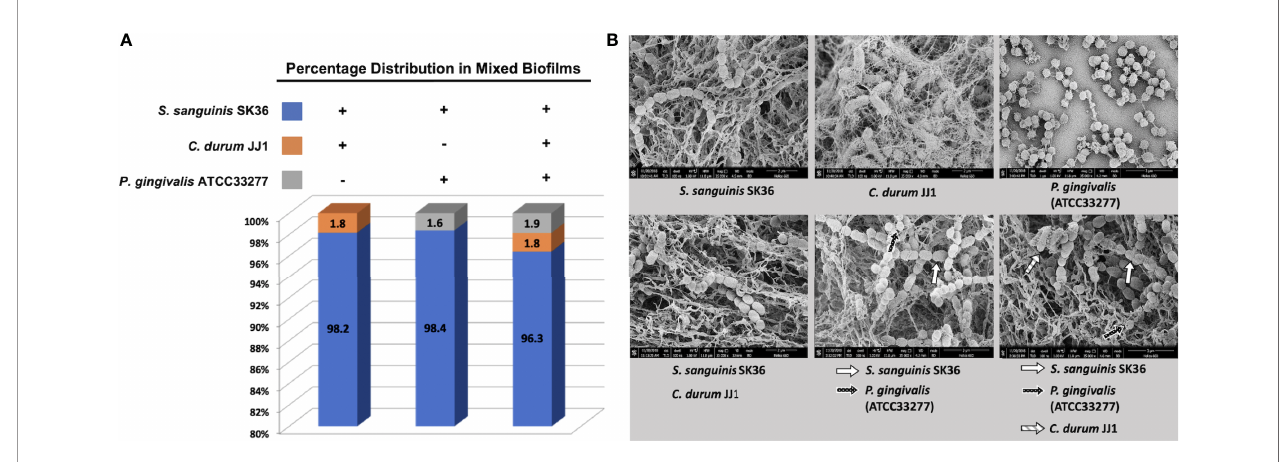
FIGURE 3 | Compositional analysis and ultrastructure of mature bio fi lms. (A) The composition of dual and multispecies bio fi lms is presented as a percentage of individual species based on the total number of bacteria determined by q-PCR. (B) The ultrastructure of mono, dual, and multispecies bio fi lms was visualized with scanning electron microscopy (SEM). Higher magni fi cation pictures (x35,000) are presented to depict the individual species morphologies in the bio fi lm. Individual species are indicated by arrows. Additional images of representative bio fi lms with lower magni fi cation are given in the supplemental material section ( Figure S3 ).